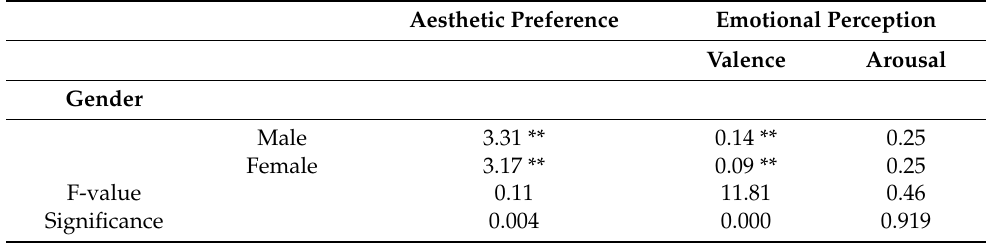
Table 6. Effects of the gender on aesthetic preference and emotional perception. Aesthetic